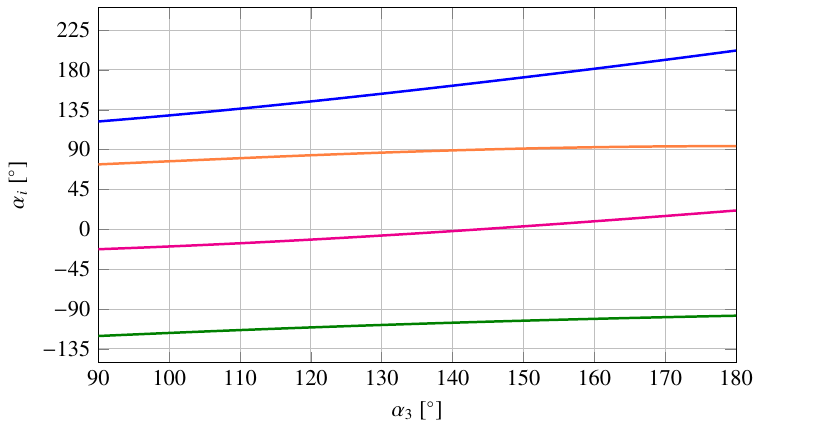
Figure 4. Angular position of the mechanism’s links. α 1 (